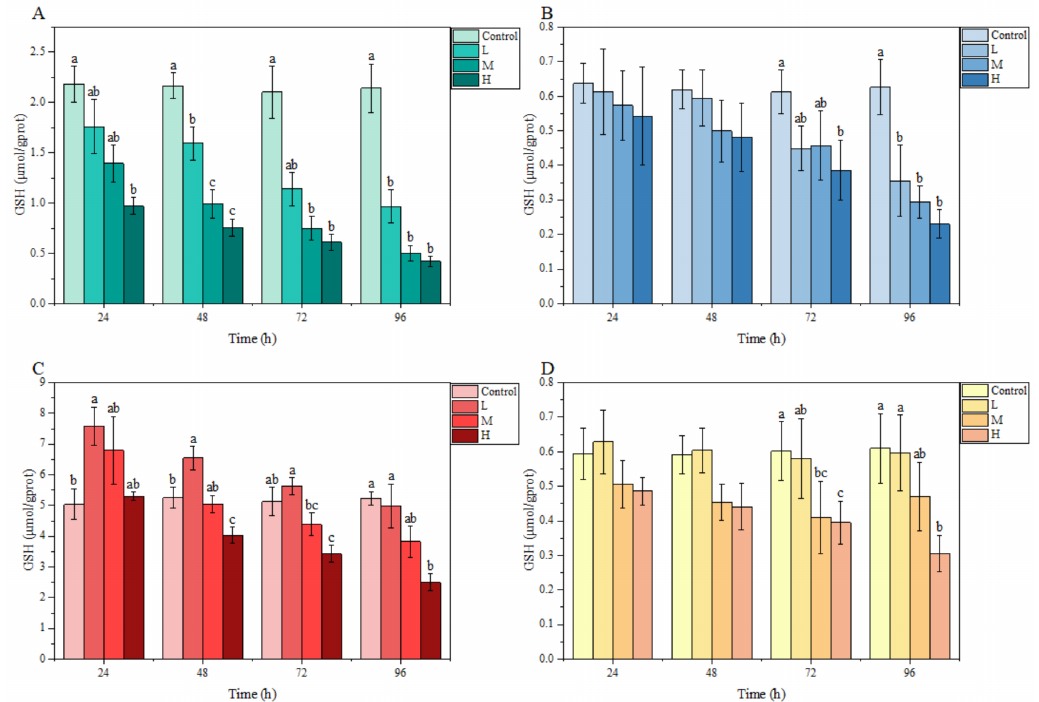
Figure 3. Effects of ammonia stress on GSH content of juvenile M. salmoides. ( A – D ) represent the GSH content in the gill, brain, liver, and kidney, respectively. The bars represent the mean ± S.D. ( n = 3). Different letters indicate statistical differences ( p <